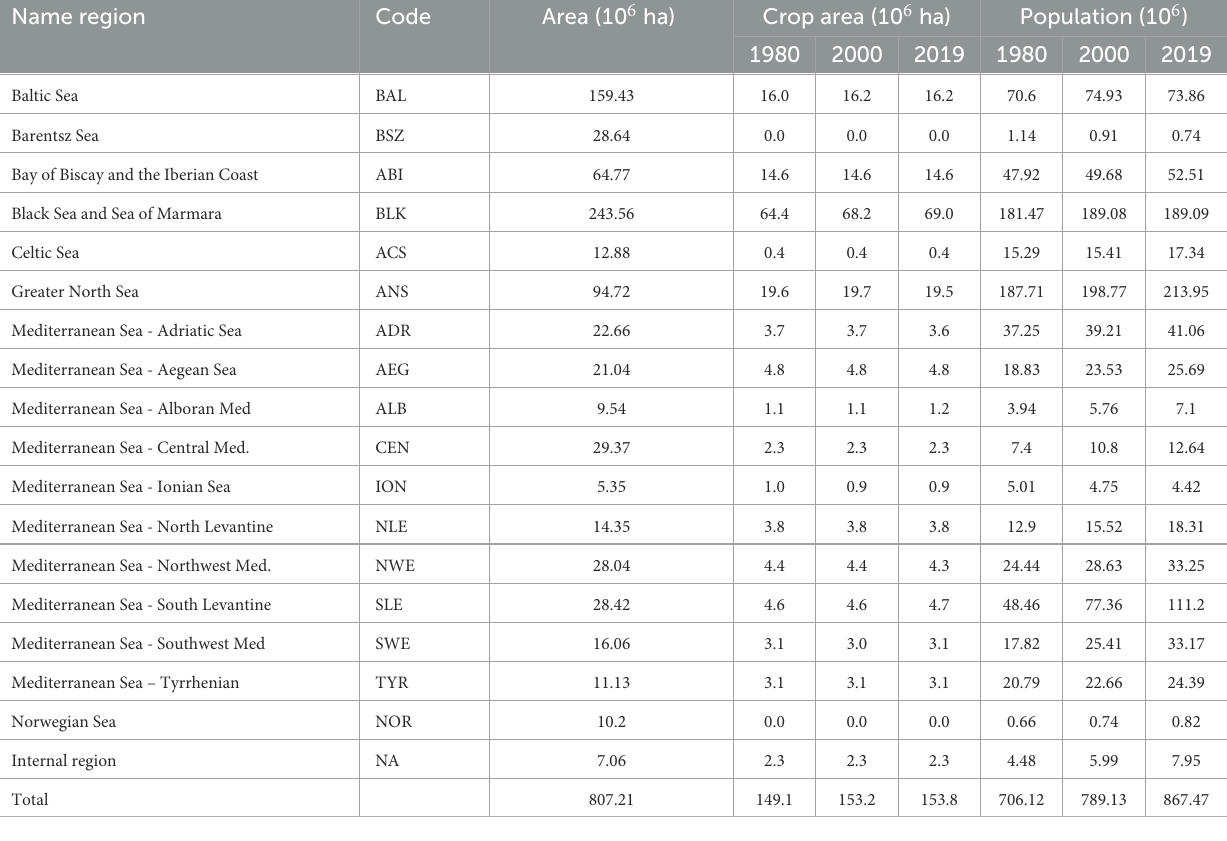
TABLE 1 Description of the study area by marine region.